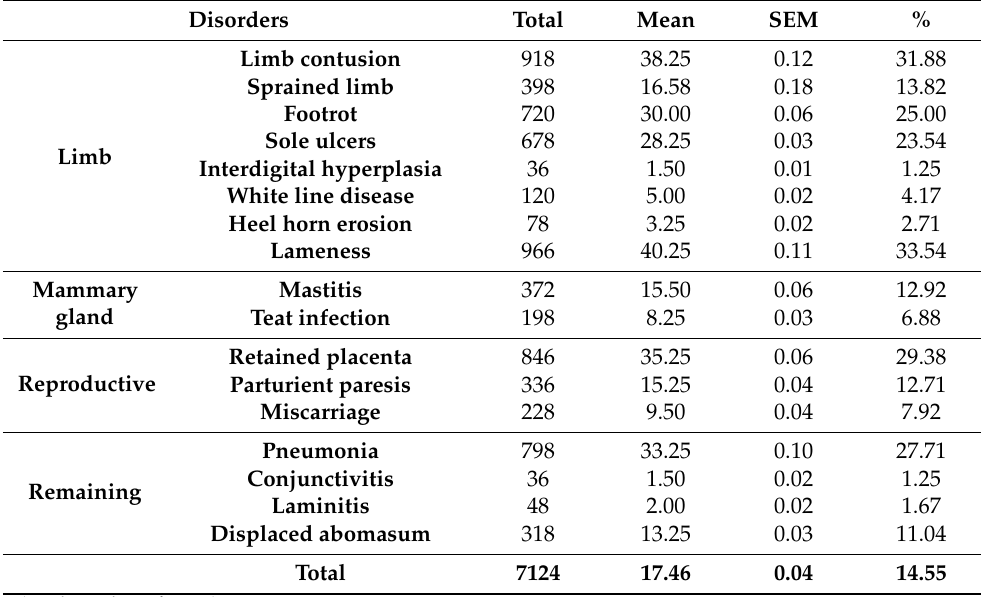
Table 3. Overall and ( Σ ) and average ( ± SEM) morbidity and the prevalence (%) of different diseases or symptoms in the entire cow population in 2015–2020.